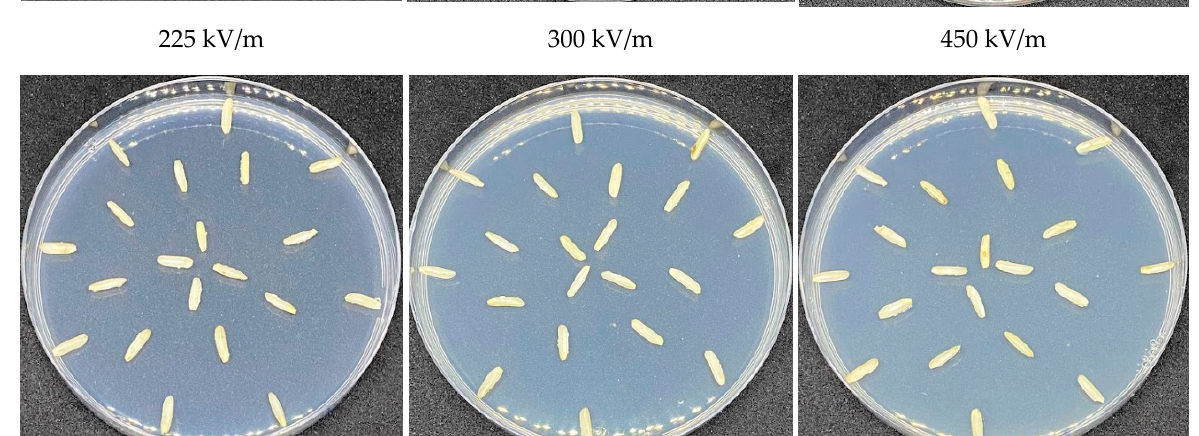
Figure 8. The fungal growth on Petri dish after treated with different electric intensity at 90 °C.